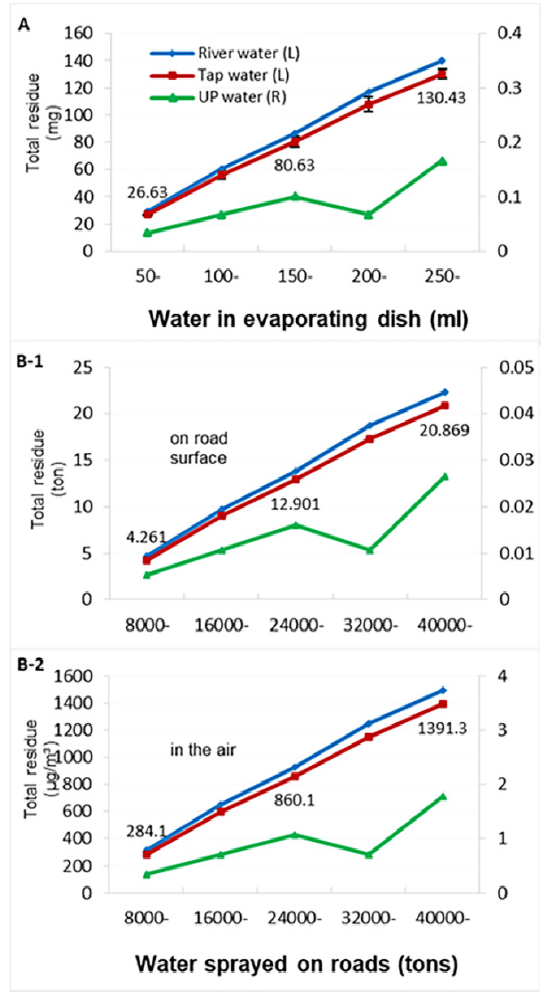
Figure 2. Total solid residue in the evaporating dish ( A ) for the three types of water and the estimated values of the residue on the road surface ( B-1 ) and in the air ( B-2 ). A : Evaporating 50 mL of water once a day for 5 d; each value on the curve was the mean from three experiments for each water sample. B-1 and B-2 : Calculated from 8000 tons of water sprayed on roads during one day and the total volume of air (1.5 × 10 10 m 3 ). In panel A , the means of the residue between the three types of water were different (DF = 2, F = 90.79, p < 0.0001), and the means of the residue between the five quantities of water were also different (DF = 4, F = 18.75, p < 0.0001). Further multiple comparisons (LSD) showed that the residues in tap water and river water were higher than those in ultrapure water ( p < 0.05), but there was no difference in the residues between tap water and river water ( p > 0.05); the order of the average residue values between different water quantities was 200 and 250 mL >100 and 150 mL > 50 mL ( p < 0.05). The marked numbers are the tap water results.